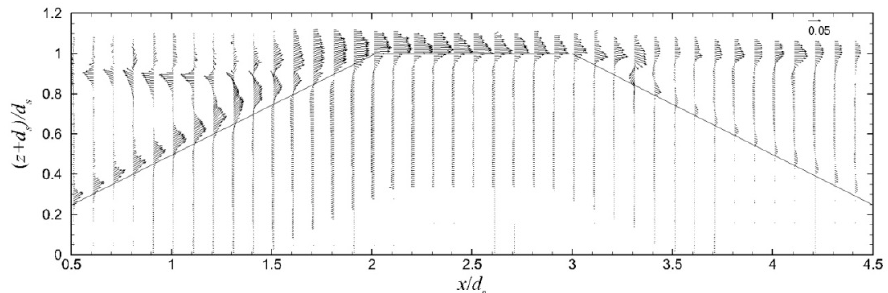
Figure 13. Period-mean velocity field for ZFB case 5. Velocity vectors are shown non-dimensionalized by ( gd S ) 1/2 in the water phase under the wave crest envelope.